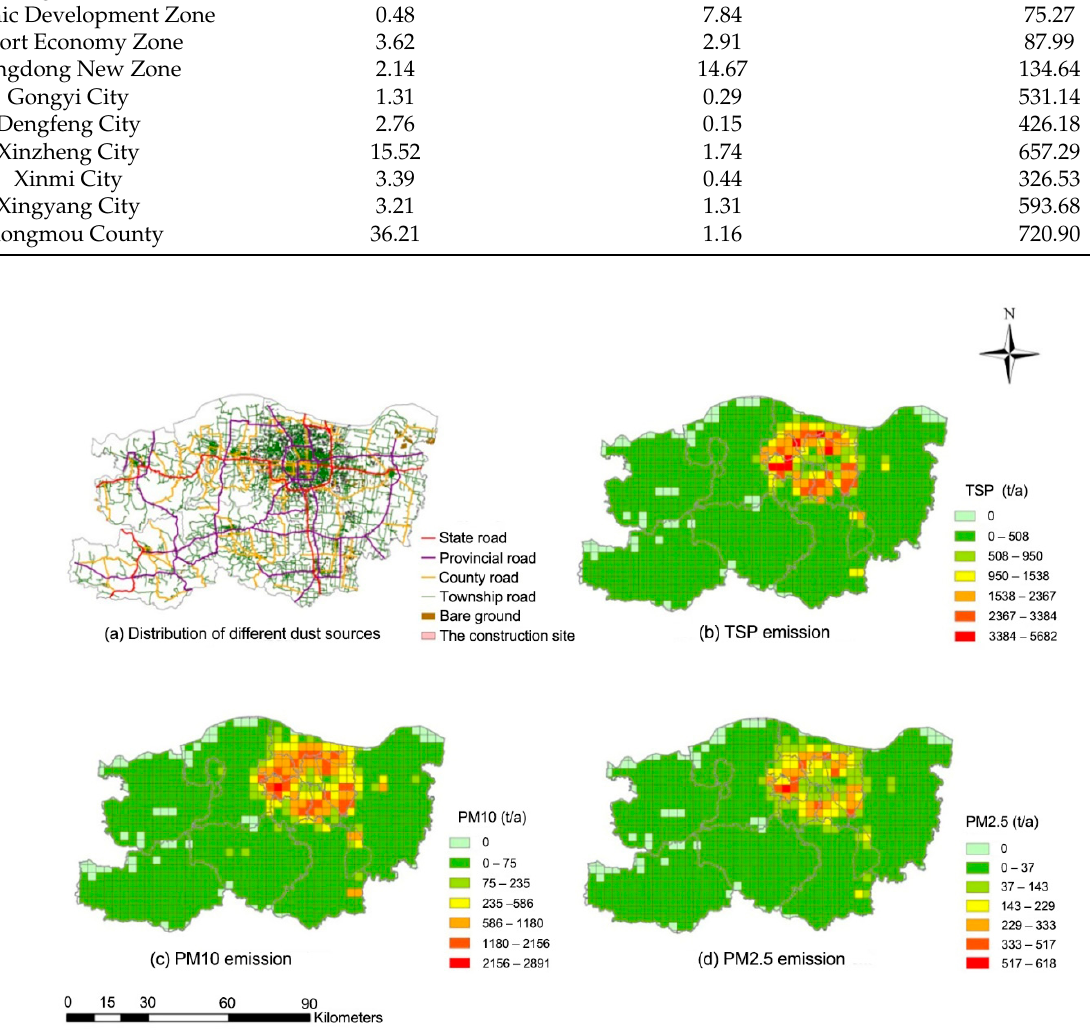
Table 4. Total emission of TSP, PM 10 and PM 2.5 from dust sources .